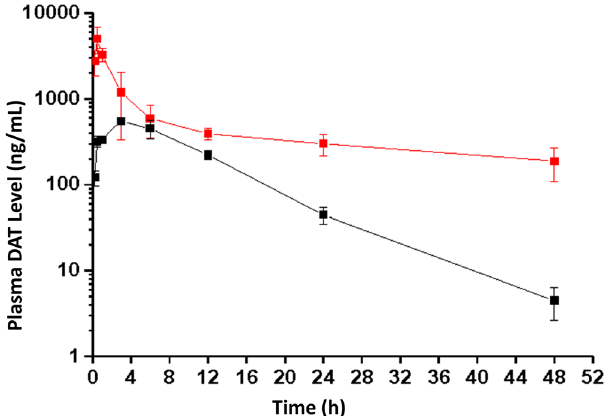
Figure 7. Mouse plasma DAT level versus time profiles. Different formulations of DAT/Cremophor EL micelles (black) and NDAT nanoformulation (red) were administered subcutaneously into mice at dose of 3 mg (DAT- equivalent)/kg body weight. NDAT was purified with dialysis (without using tangential flow filtration, TFF) before injection. Data are shown as mean ± SD (n = 4).